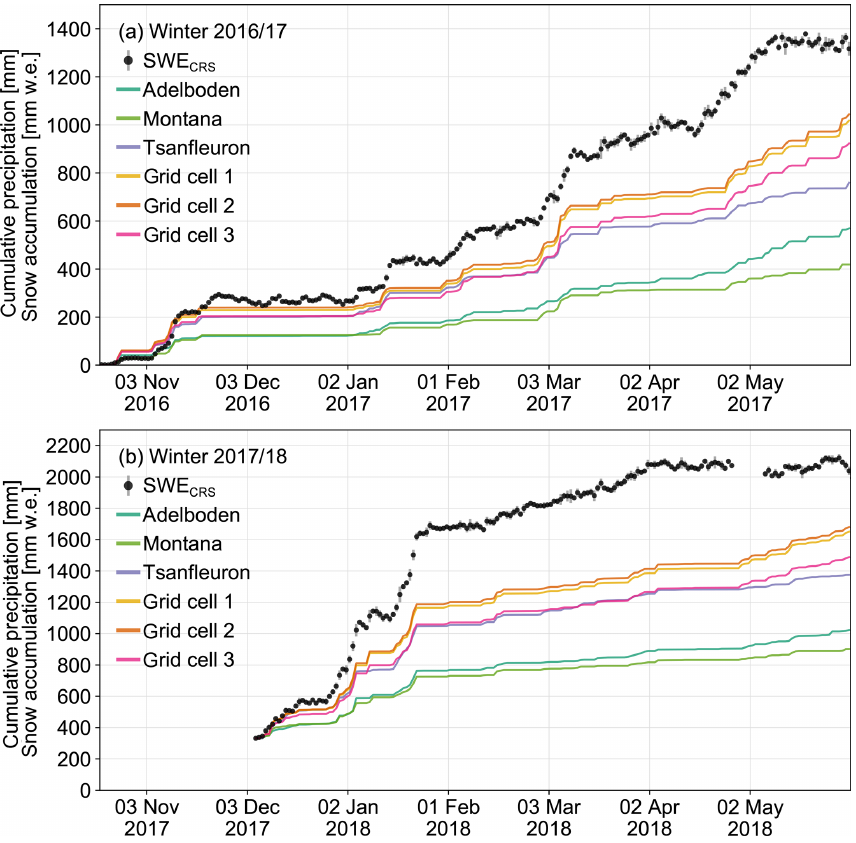
Figure 9. Cumulative precipitation and snow accumulation of (a) winter 2016/17 and (b) winter 2017/18. Black dots show daily SWE observations with their standard deviations. Colored lines represent all cumulative precipitation time series. Table 7. Scaling factors resulting in a minimal MAE. Two different approaches are presented; one factor applied and three factors applied distinguishing between the precipitation phases (solid, mixed and liquid). One factor Three factors All MAE (mmw.e.) Solid Mixed Liquid MAE